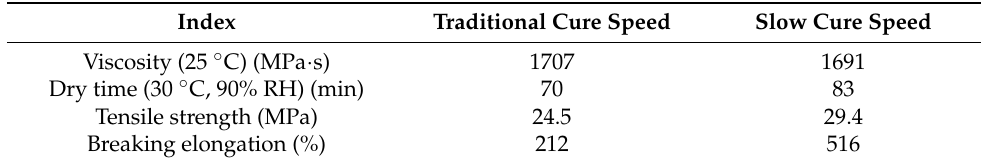
Table 2. The index of PU with different cure